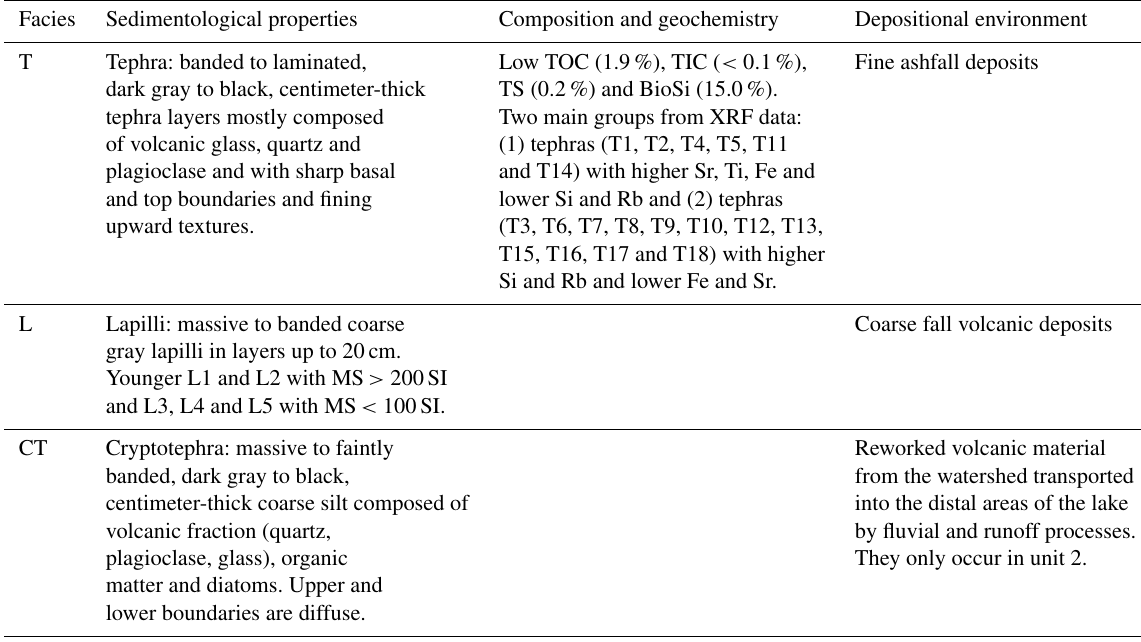
Table 4. Depositional and compositional characteristics of LdM volcanic facies.